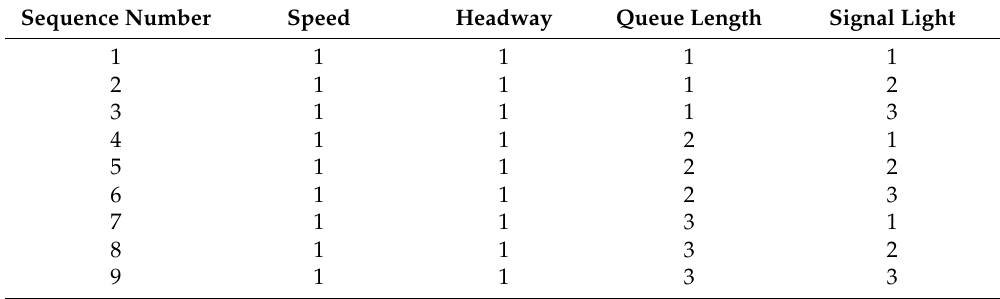
Table 3. Rules of the observation combination sequence (partial).